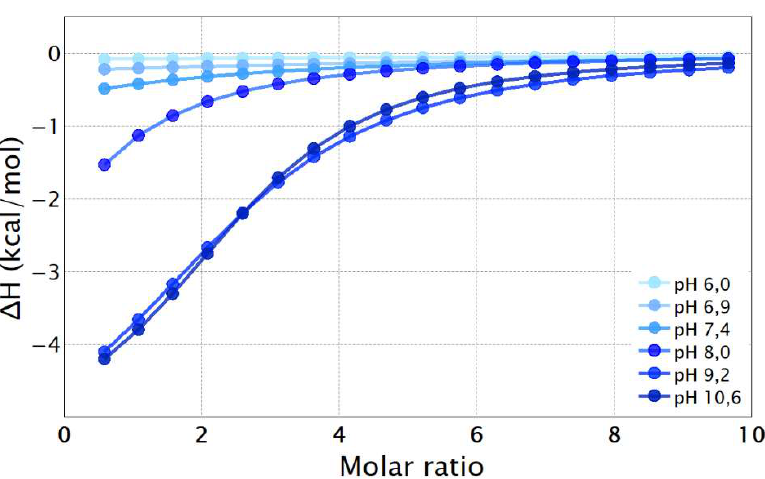
Figure 3. Normalized heat plots for sorbitol binding to TBA at different pH. Titration conditions: 300 μL of 0.5 mM TBA in the cell and 25 mM of sorbitol in the titration